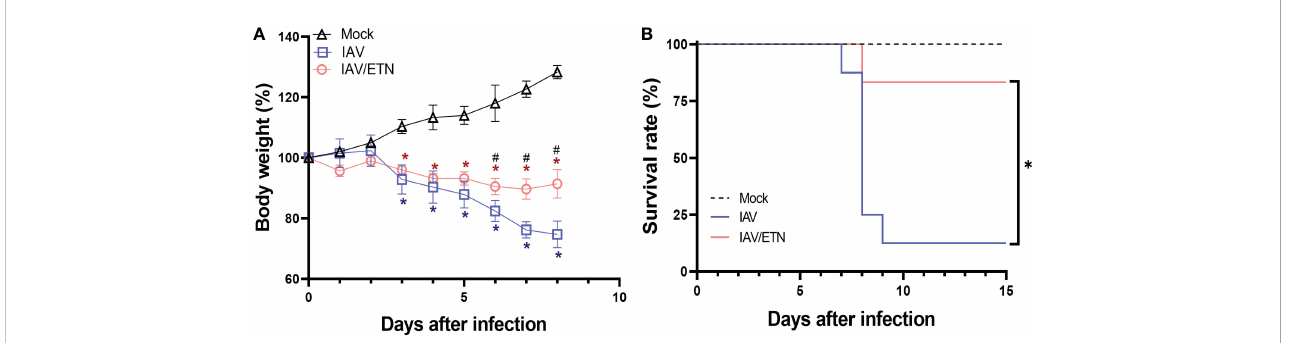
FIGURE 4 Etanercept reduced weight loss and improved survival during lethal IAV infection in mice. C57Bl/6 mice were inoculated intranasally with 10 3 PFU of IAV. Six hours postinfection, animals were treated intraperitoneally with 2.5 mg/kg etanercept (ETN). Mice received a daily dose of ETN for 7 days and were monitored for survival (A) and body-weight loss (B) analysis. Data are shown as the percentage of survival and weight. The graphs are representative of three independent experiments. * P < 0.05 in comparison to the IAV-infected untreated group; # P < 0.05 in comparison to Mock